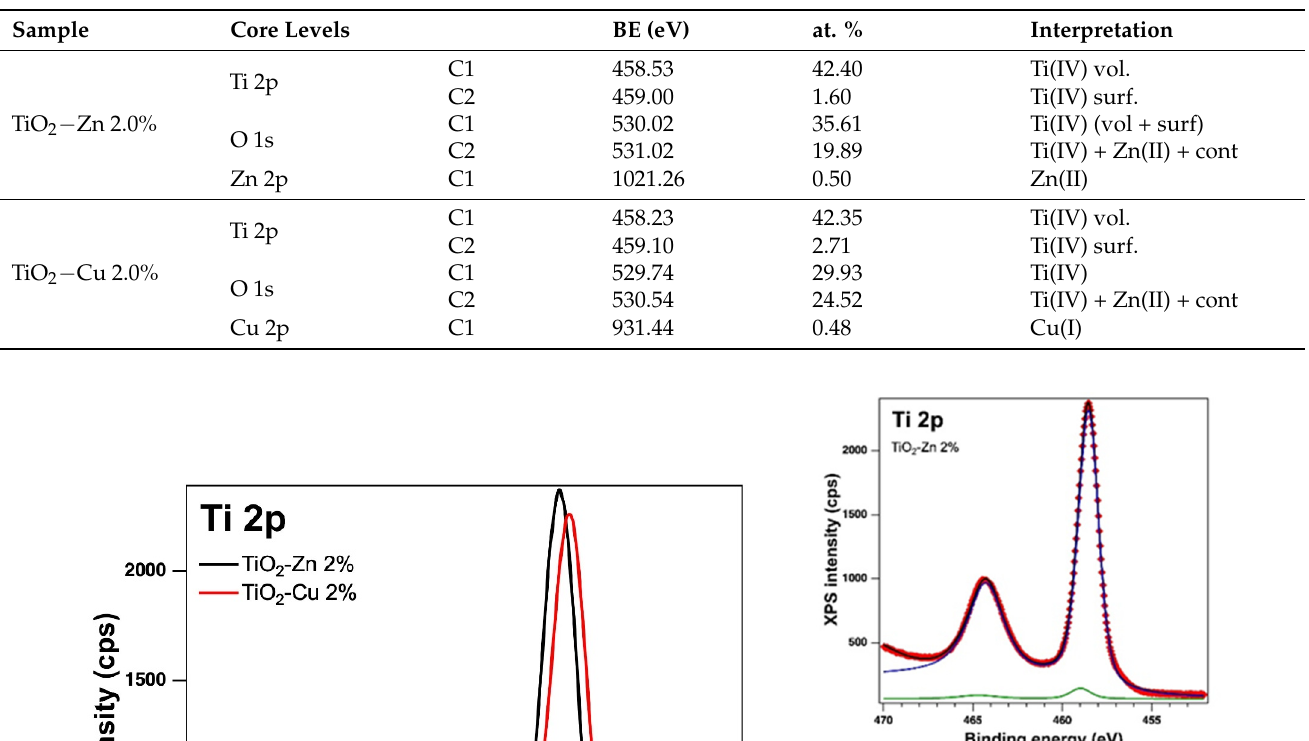
Table 1. Binding energies (BE) at. % and interpretation of the components of the core levels of interest for the samples prepared by sol-gel method.